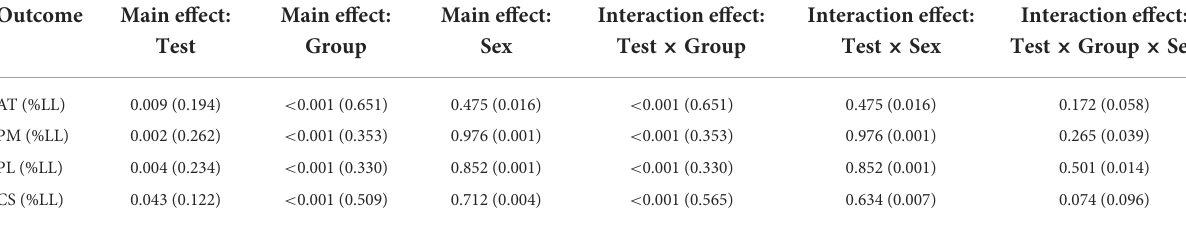
TABLE 3 Main and interaction effects of the repeated measures ANCOVA * per outcome